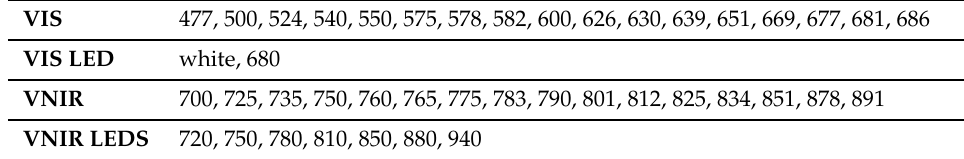
Table 1. Selected wavelengths and corresponding LED light wavelengths.